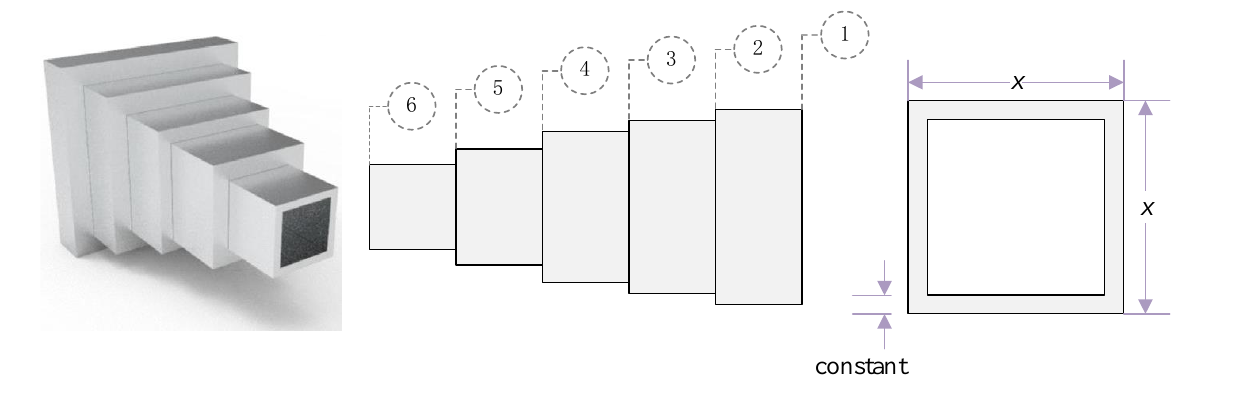
Figure 13. Cantilever beam structure. Table 10. Statistical results of the cantilever beam design